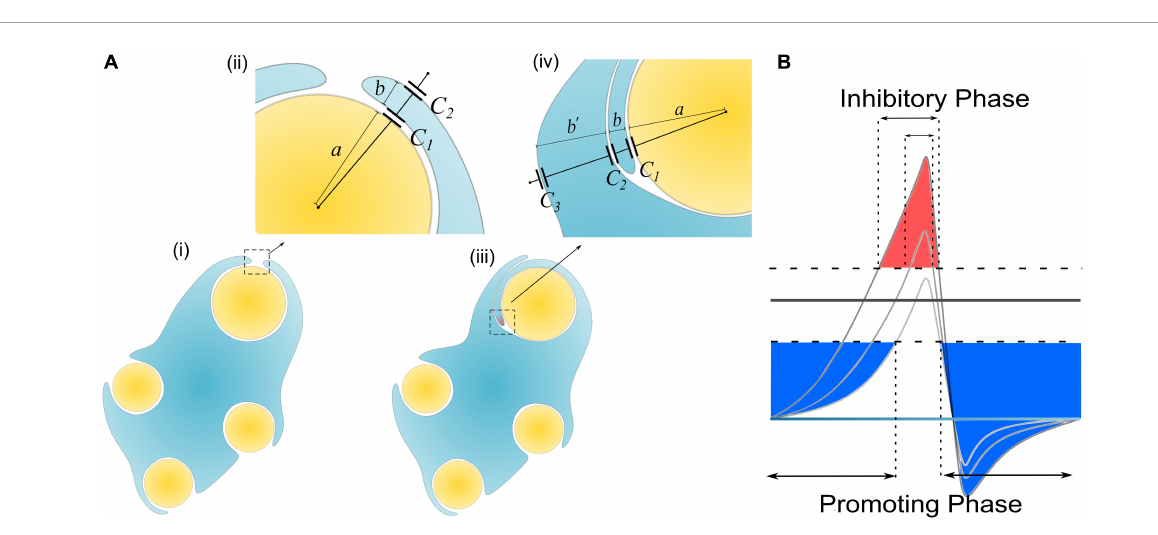
FIGURE7 (A) The scenario when an SC of remak bundle ensheathes a large axon: (i, ii) Only one layer of SC is wrapped; (iii, iv) when the SC tries to wrap the second layer; (B) A more decayed action potential induces a shorter inhibitory phase (red